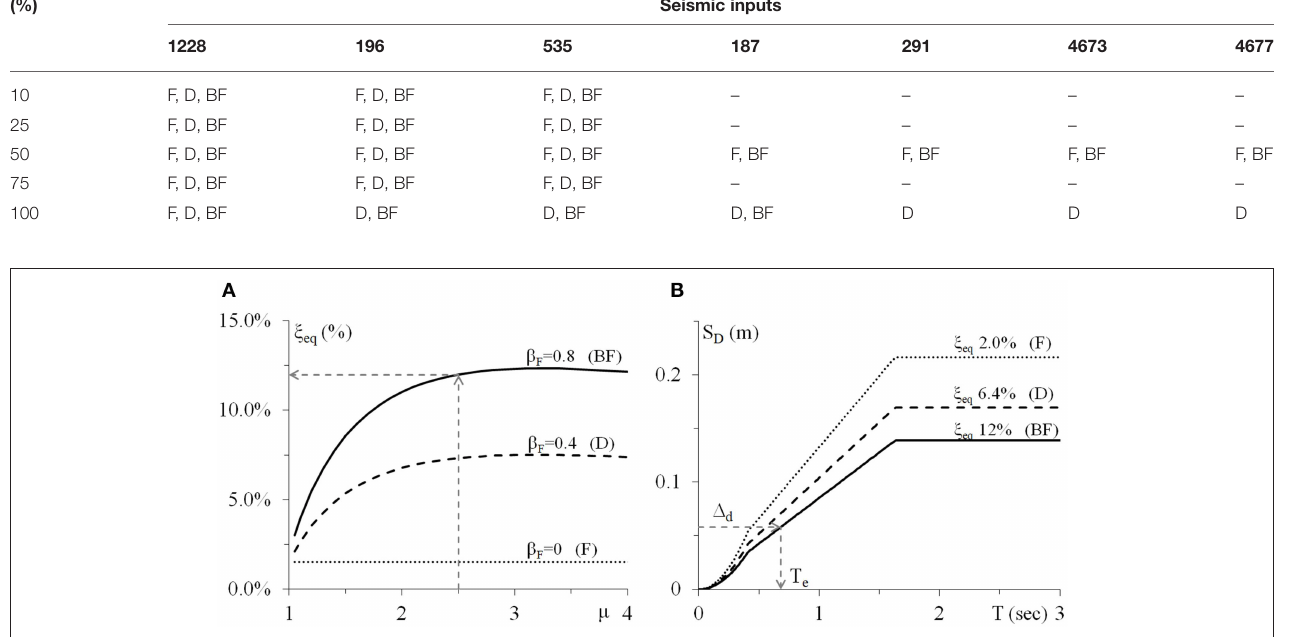
FIGURE 7 | (A) Equivalent viscous damping vs. ductility of post-tensioned timber structures for different re-centering ratios; (B) Design displacement response spectrum.